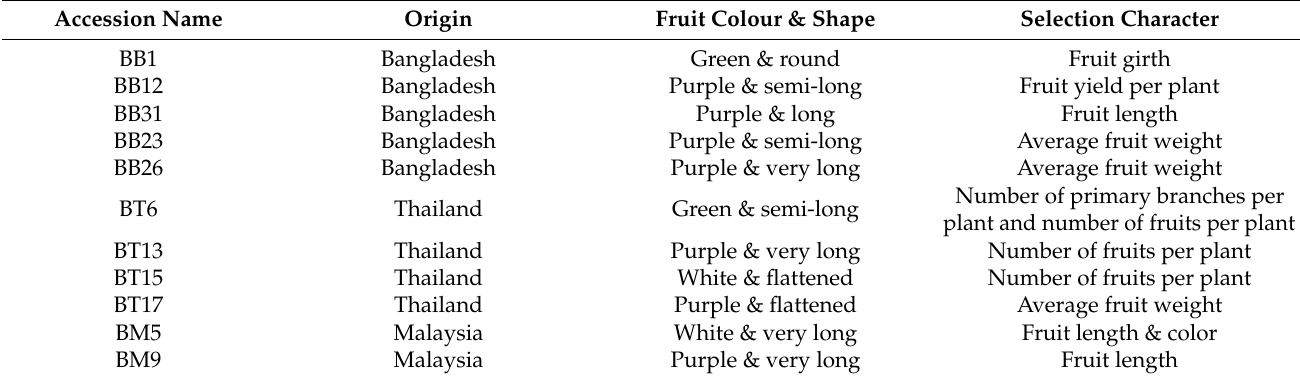
Table 1. Eggplant materials used in this study including their origin and main